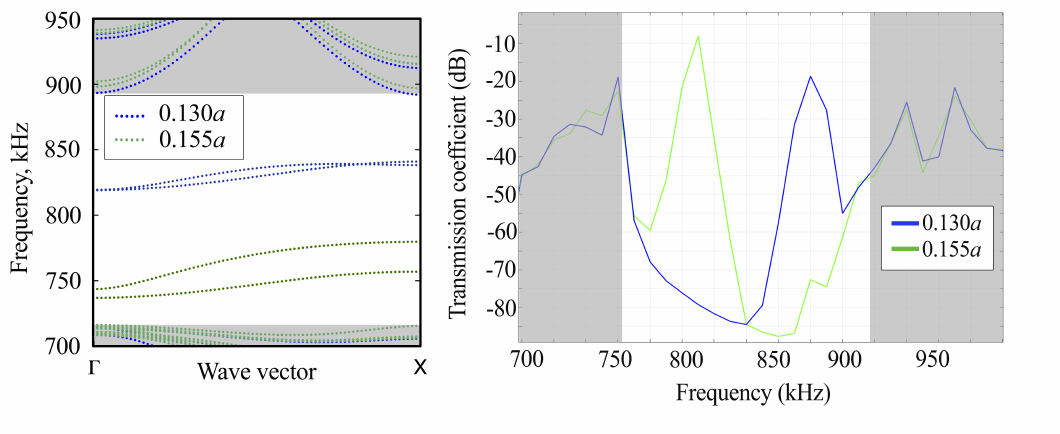
Figure 5. ( left ) Dispersion curve and ( right ) transmission spectra for r i = 0.130 a to 0.155 a .